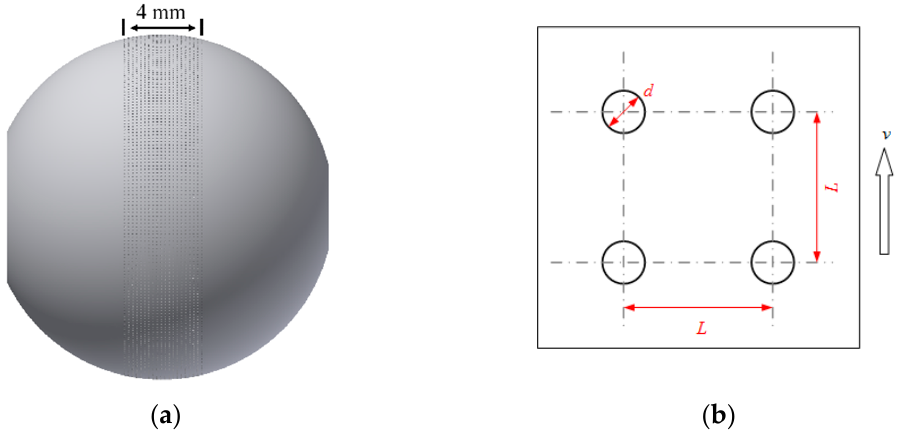
Figure 2. Circle-dimple textured ball: ( a ) 3D schematic diagram and ( b ) texture parameter diagram.